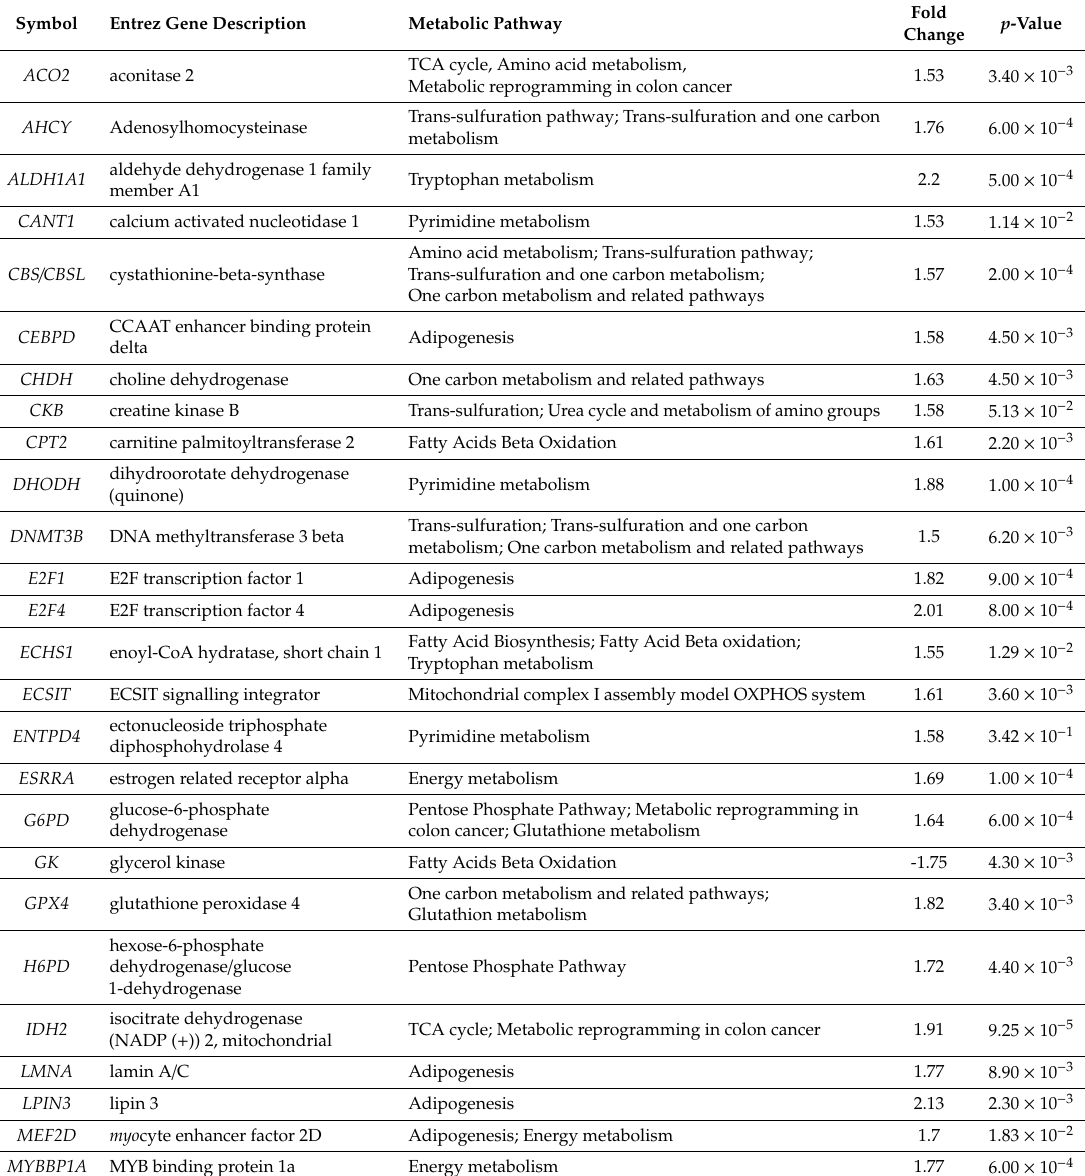
Table 2. miR-146a-5p a ff ects expression of genes involved in key metabolic pathways. The table shows selected DEGs in RCC cells transfected with miR-146a-5p mimic, compared to cells transfected with non-targeting control oligonucleotide with functions in di ff erent metabolic pathways identified by biological pathway analysis with WikiPathways included in TAC